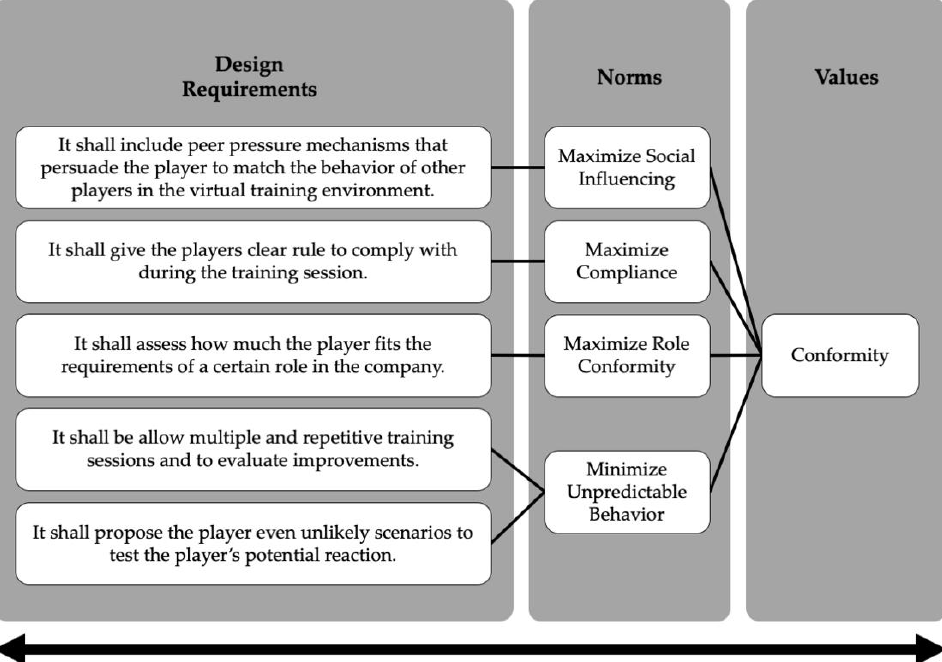
Figure 11. Prototypes of simulation-based VR training tools for augmenting workers’ cognitive capabilities.